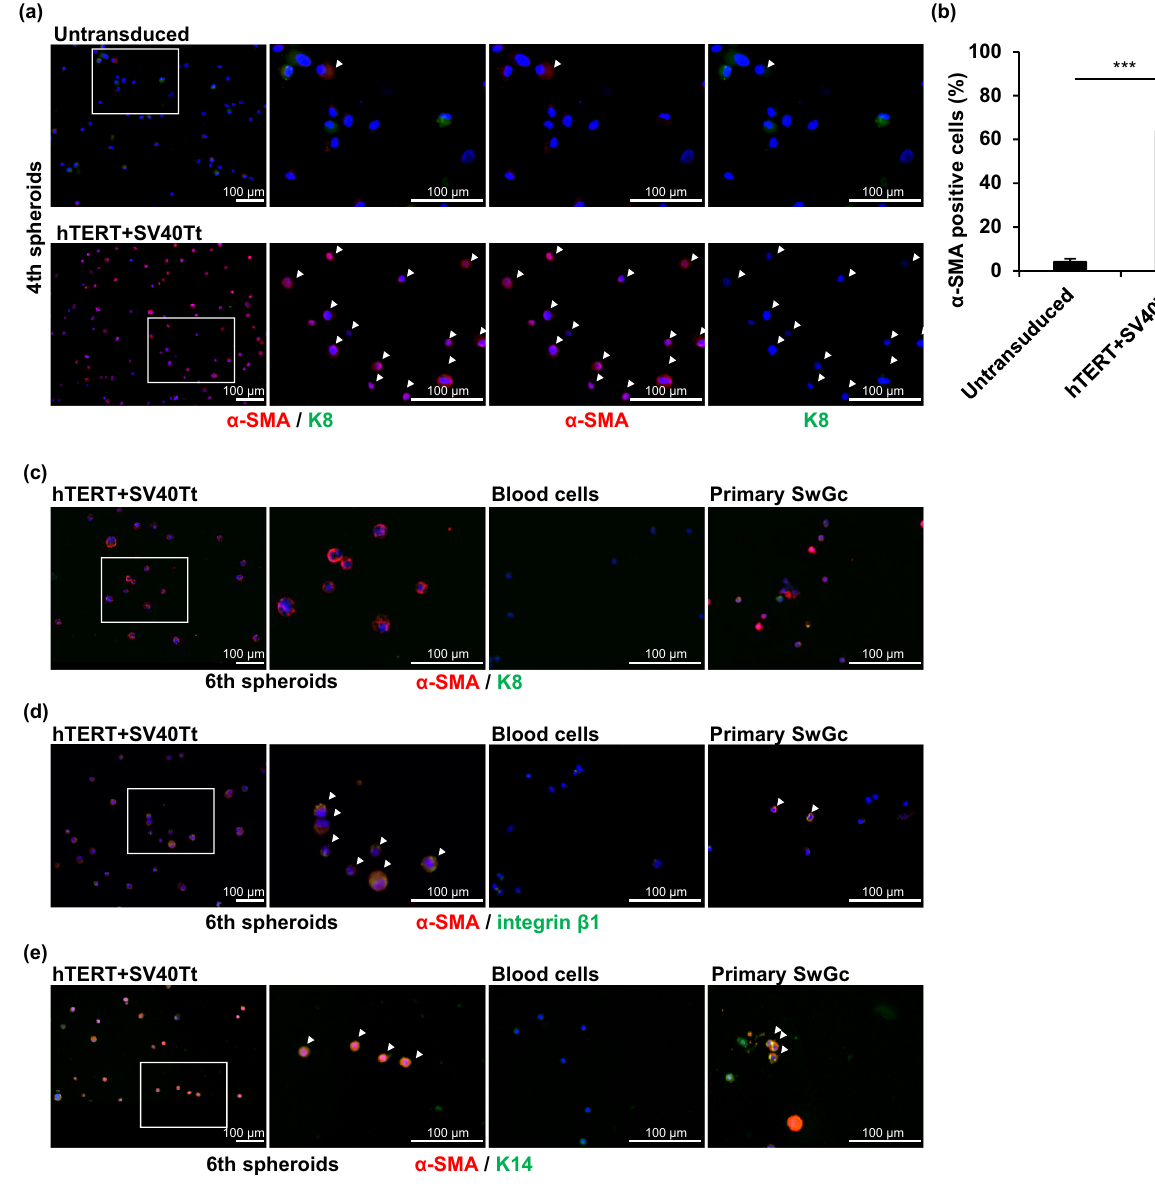
Figure 3. Immortalized sweat gland cells exhibit myoepithelial cell properties. ( a ) Immunofluorescence of human telomerase reverse transcriptase and Simian Virus 40 large T and small t antigen (hTERT + SV40Tt) gene-transduced cells and untransduced cells in the 4th spheroids for α-smooth muscle actin (α-SMA) and keratin 8 (K8). ( b ) Rate of α-SMA-positive and K8-negative cells in hTERT + SV40Tt gene-transduced cells and untransduced cells at the 4th spheroids. At least 50 cells were counted under each condition. Data are presented as the mean ± S.E. of five independent experiments (n = 5). ***P < 0.001. ( c – e ) Immunofluorescence of hTERT + SV40Tt-transduced cells in the sixth spheroid, blood cells (negative control), and primary sweat gland cells (primary sweat gland cells; positive control) for α-SMA and K8 ( c ), α-SMA and integrin β1 ( d ), and α-SMA and keratin 14 (K14) ( e ). Arrowheads indicate α-SMA-positive cells ( a ), α-SMA and integrin β1 positive cells ( d ), and α-SMA and K14 positive cells ( e ). The second panels from the left are magnified views of the boxed areas in the left panels. Scale bars: 100